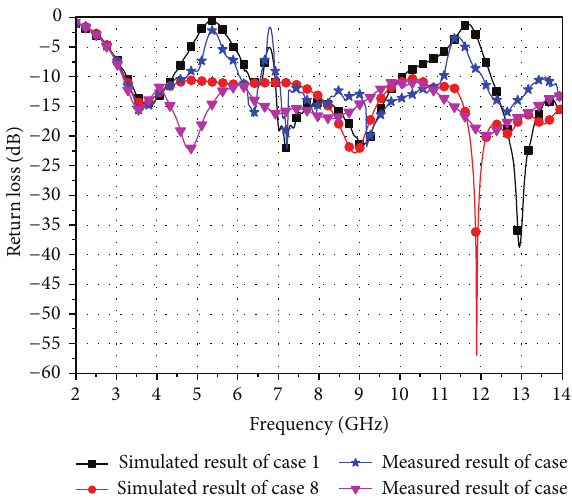
Figure 15: Return losses of fabricated CRA C in case 1 and case